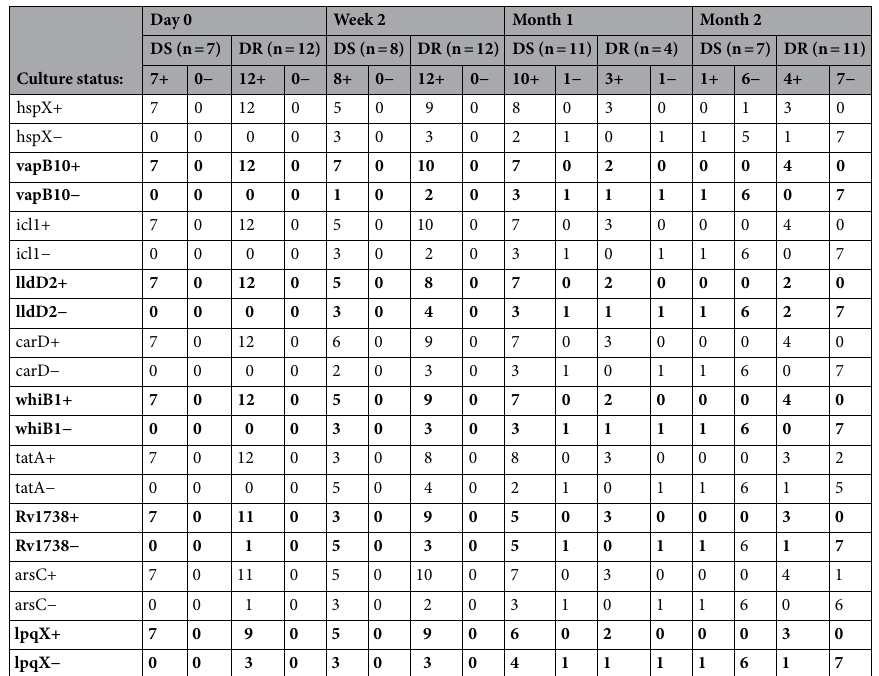
Table 6. qRTPCR positivity by ten abundantly expressed Mtb mRNA targets in comparison to culture for sputa from subjects with drug sensitive (DS) or drug resistant (DR) TB receiving first-line or second-line therapies, respectively. n-values represent number of sputum available at each timepoint for each cohort (see “Materials and methods” section); Cycle threshold (Ct) values can be found in Table S19. Rows corresponding to different mRNA targets are alternately bolded for visual